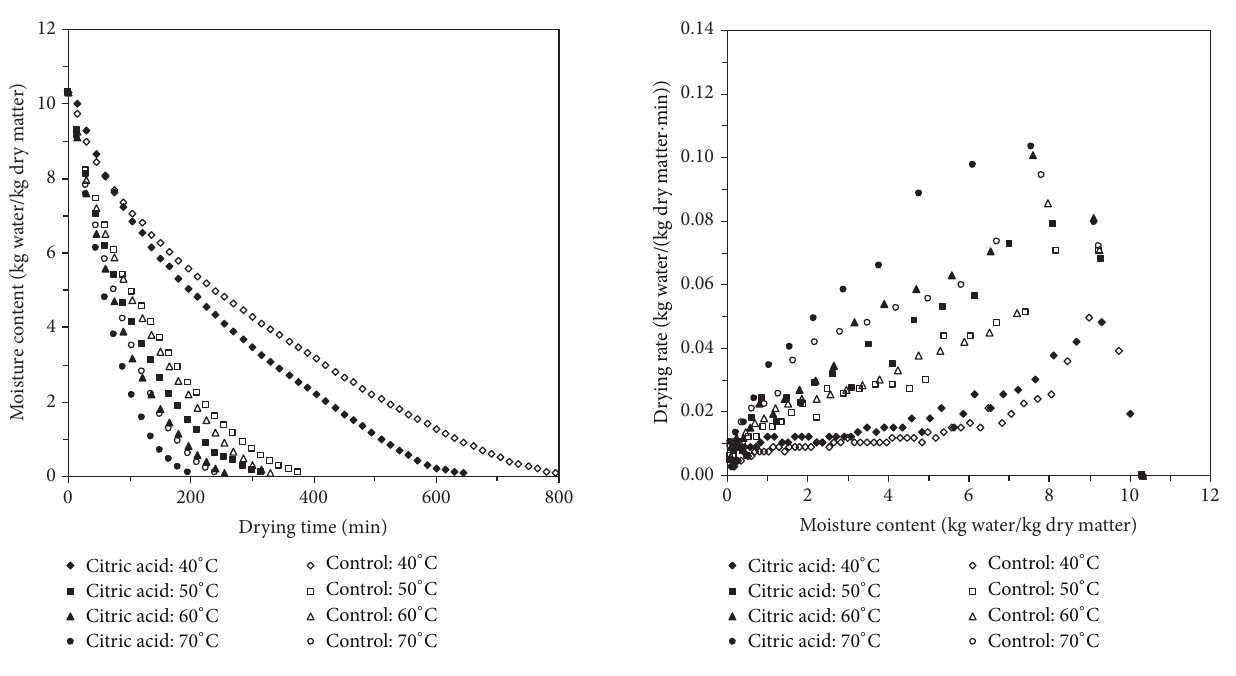
Figure 1: Drying curves of mushroom slices with a citric acid solution or without treatment at different temperatures.